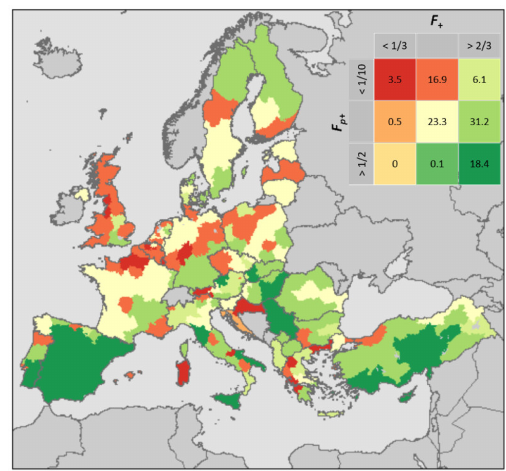
Figure 8. Synthetic representation of the performance of dekadal fAPAR anomalies in reproducing the yearly yield variations during the local optimal period. The inserted legend shows the values of F p + and F + for each category, with the numbers inside each square representing the percentage (%) of the total NUTS 2 regions (out of 240) that fall under each category.